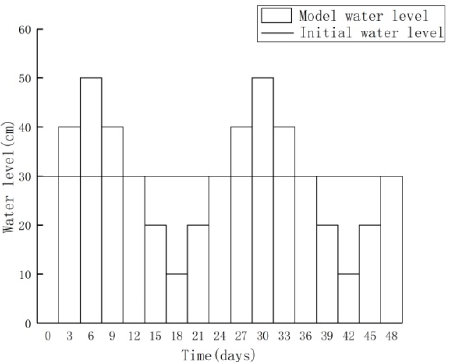
Figure 3. Time variation of water level.